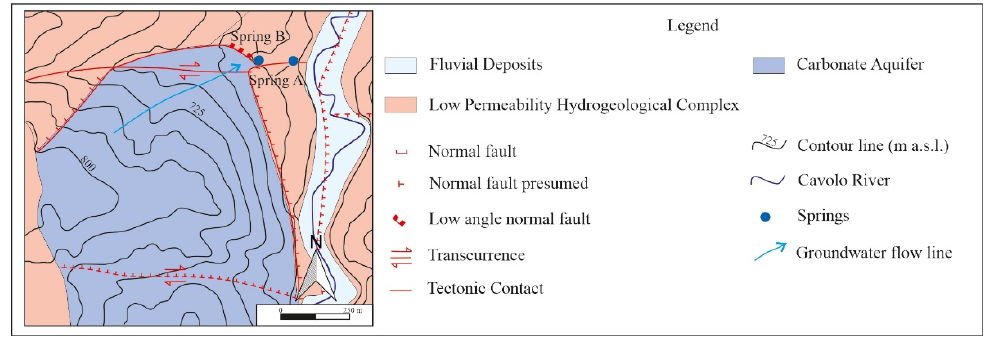
Figure 2. Hydrogeological map of the study area (from Rizzo et al., 2020 modified) [35]; the blue points show the location of the investigated springs A and B (the geological sketch is taken from Olita, 2018, modified) [24].